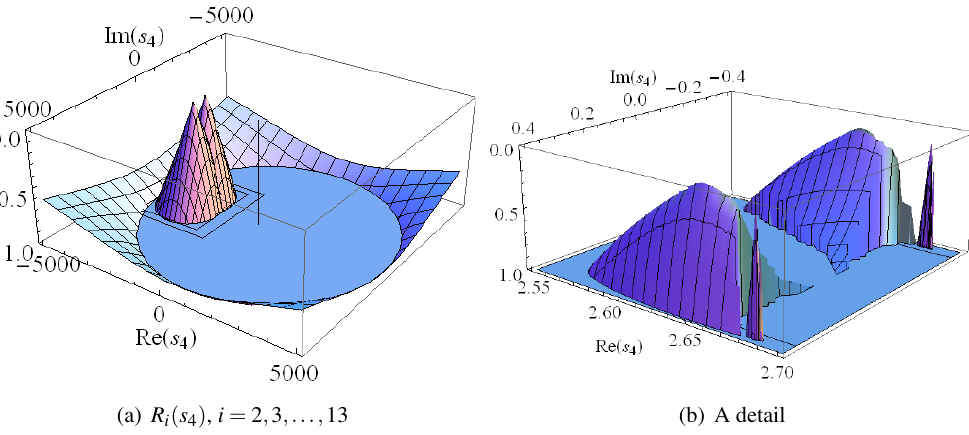
Fig. 5 Stability functions of the strange fixed points R i ( s 4 ) , i = 2 , 3 ,..., 13 for m =